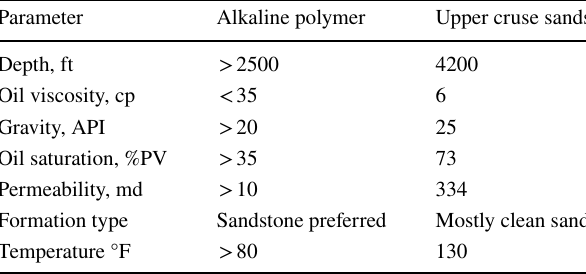
Table 1 Showing a comparison of the required characteristics for